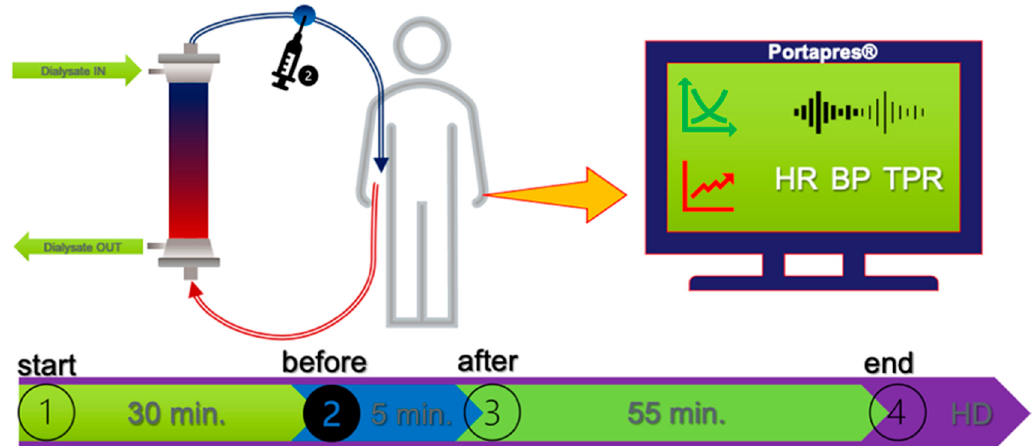
Figure 1. Study protocol.